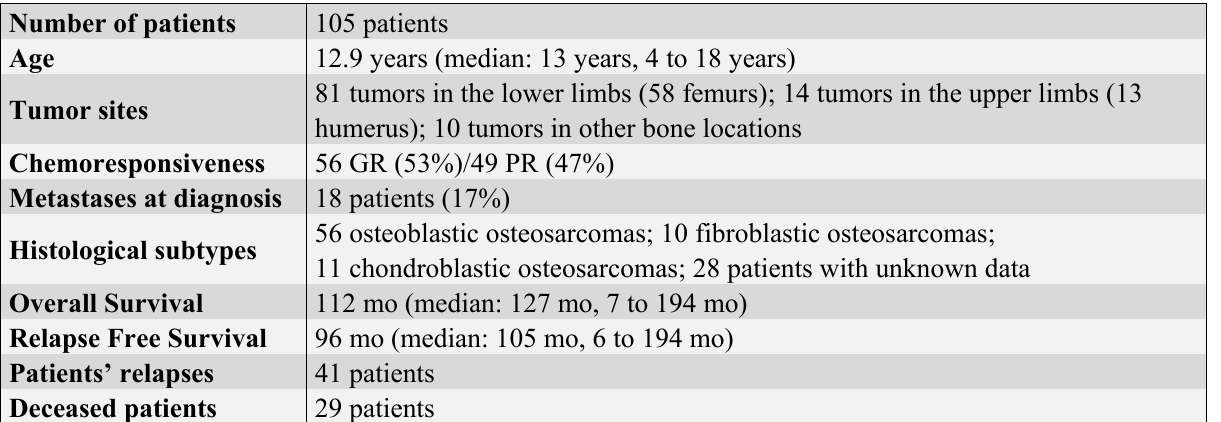
Table 1. Summary of patients’